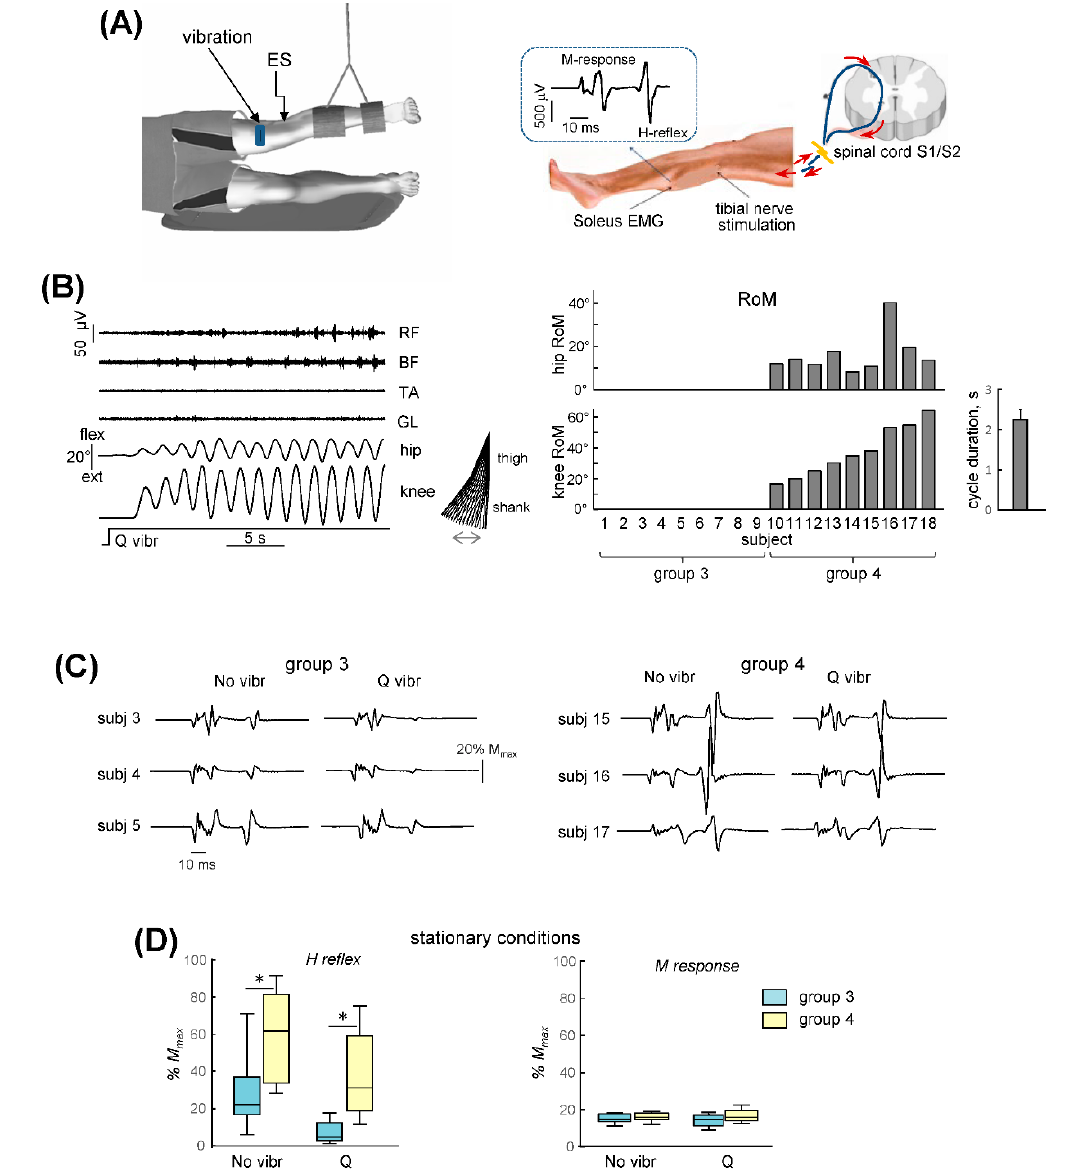
Figure 5. General characteristics of non-voluntary rhythmic leg air-stepping movements and H-reflex evaluation. ( A )—experimental setup and soleus H-reflex measurements. Quadriceps (Q) muscle vibration was used to evoke non-voluntary limb oscillations, while ES of the tibial nerve was used to evoke the H-reflex. The arms and the right leg were stationary. ( B )—left panel illustrates an example of evoked movements and EMG activity in the subject who demonstrated prominent non-voluntary limb oscillations and right panels show the ROM of hip and knee oscillations in all individual subjects (ordered by the magnitude of the ROM in the knee joint). The subjects were divided into two groups: with and without rhythmic leg movements (groups 4 and 3, respectively). Cycle duration (mean + SE) of evoked oscillations is also shown for group 4. RF—rectus femoris, BF—biceps femoris, TA—tibialis anterior, LG—lateral gastrocnemius. ( C )—examples of the H-reflexes in subjects from group 3 (subj. 3, 4, 5) and group 4 (subj. 15, 16, 17) during stationary conditions: no vibr. and Q vibration. In the latter case, 2 stimuli were delivered after the onset of vibration but prior to the appearance of non-voluntary leg movements (as in the case of upper limb experiments, Figure 2B). ( D )—H-reflex amplitudes (median and quartiles) and M-responses for the two groups of subjects. Asterisks denote significant differences between the two groups.